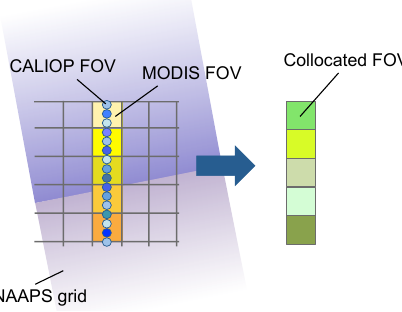
Figure 1. Schematic showing the collocation process match- ing MODIS, CALIOP, and NAAPS. Multiple CALIOP fields of view (FOVs) are mapped to a single MODIS FOV and averaged. Each satellite FOV is then assigned a NAAPS grid that is closest in space and time. This process is repeated for 10 years of A-Train orbit to compose the CCARA